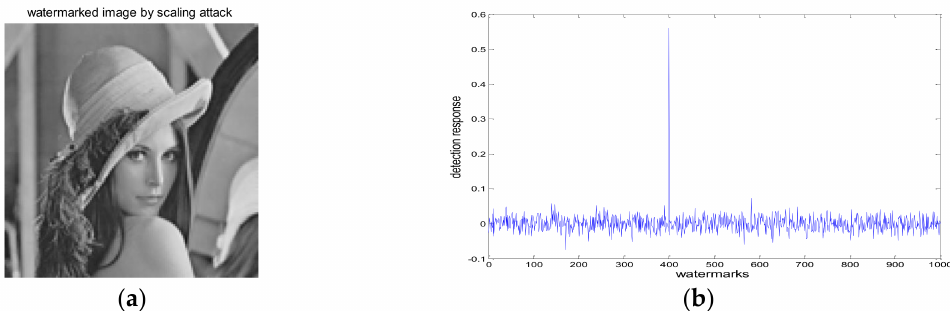
Figure 9. ( a ) Scaling attack (scaling factor is 0.25); ( b ) detector response.